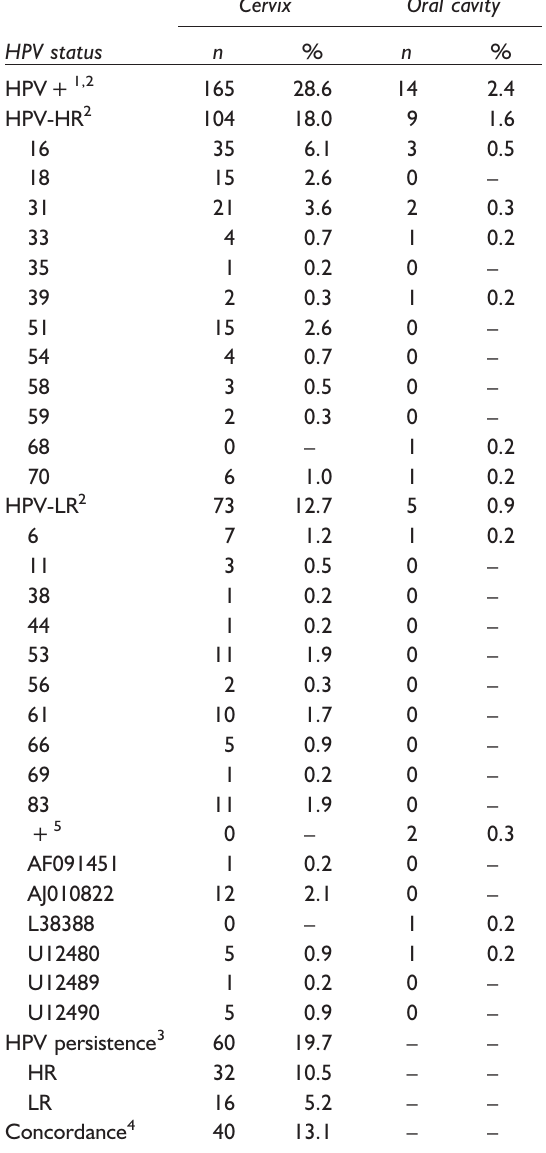
Table 2 HPV prevalence and types in the cervix and oral cavity of pregnant women ( n =577) Cervix Oral